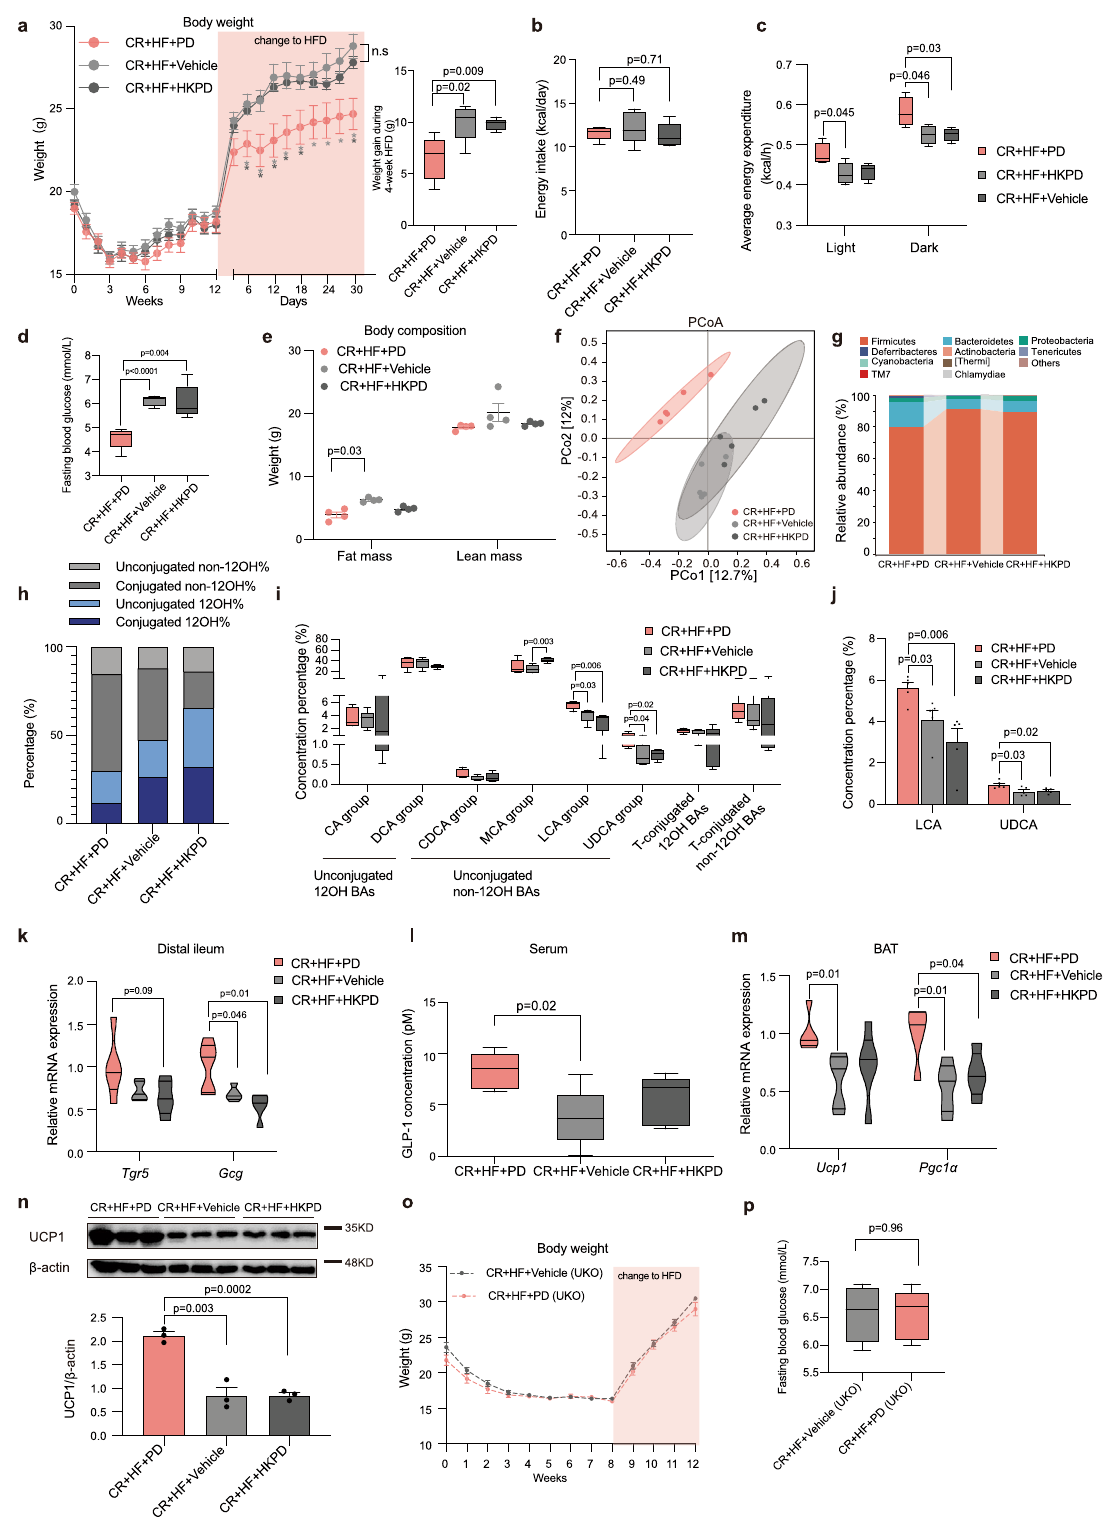
in obesity development, we performed an experiment utilizing HFD mice supplemented with 0.5% (w/w) UDCA after CR (Supplementary Fig. 7a). During HFD, the weight gain of the UDCA treatment group was signi fi cantly decreased (Fig. 7a), while the average energy intakes at the fi rst week of the recovery (Fig. 7b) and the fecal energy excretion (Supplementary Fig. 7b) showed no signi fi cant differences between CR + HF + UDCA